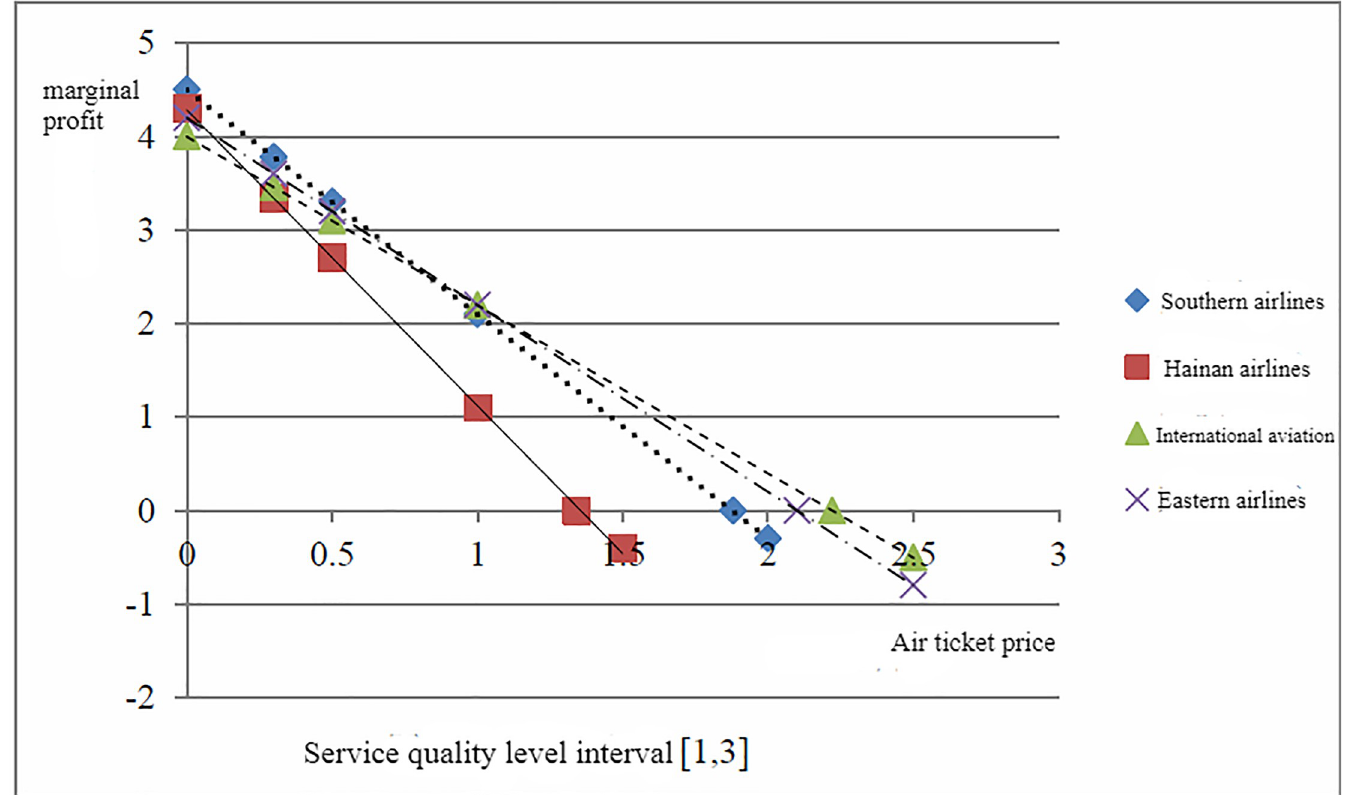
Fig 3. Low-level service quality level fare